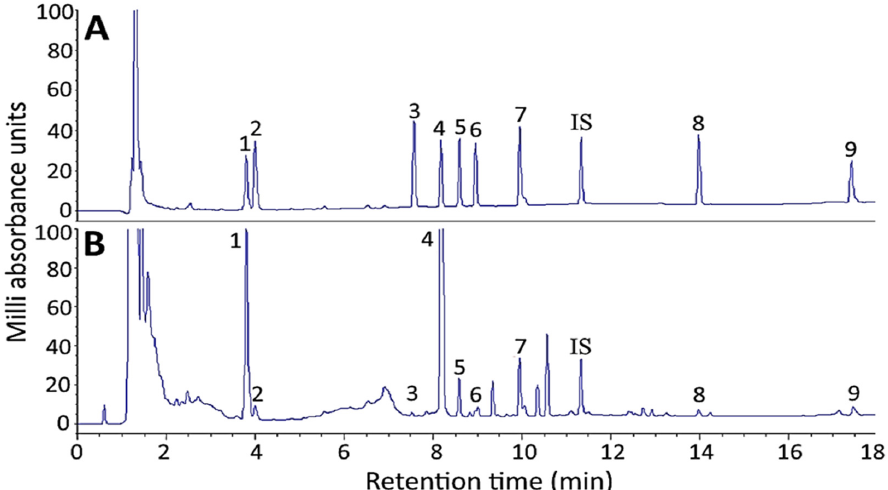
Figure 2. HPLC chromatograms for separation of ginsenosides in standards mixture ( A ) and American ginseng root residue sample ( B ). Separation conditions: column type, Supelco Ascentis Express C18 column; column dimension, 150 × 4.6 mm ID and particle size 2.7 µ m; mobile phase, deionized water and acetonitrile; flow rate, 1 mL/min; column temperature, 50 ◦ C; detection wavelength, 205 nm. Peaks: 1, Re; 2, Rg1; 3, Rf; 4, Rb1; 5, Rc; 6, Rb2; 7, Rd; IS (internal standard), saikosaponin